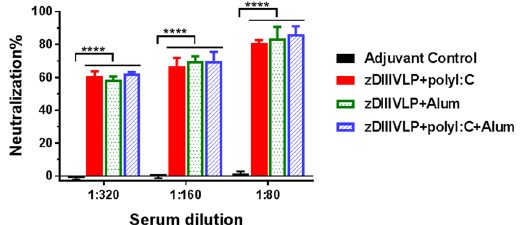
Figure 6. Neutralization of ZIKV by anti-HBcAg-zDIII serum. Pooled sera from week 5 of mice received PBS + Adjuvant or HBcAg-zDIII + indicated adjuvant were serially diluted and incubated with ZIKV prior to infection of Vero cells. A PRNT assay was performed as described in Materials and Methods to assess ZIKV- specific neutralizing antibodies in the sera. Mean neutralization % and SD from three independent experiments with technical triplicates for each sample are presented. **** Indicates p values < 0.0001 of HBcAg-zDIII- immunized serum compared to that of PBS + adjuvant